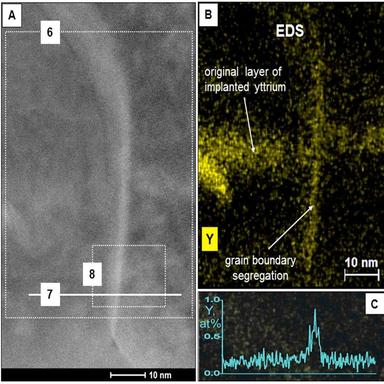
(A) - Boundary between two Cr2O3 grains, found in the area indicated by rectangle "5" in at a higher magnification; (B) - Yttrium distribution map for area "6" in A; (C) - yttrium distribution along the line marked "7" in A.